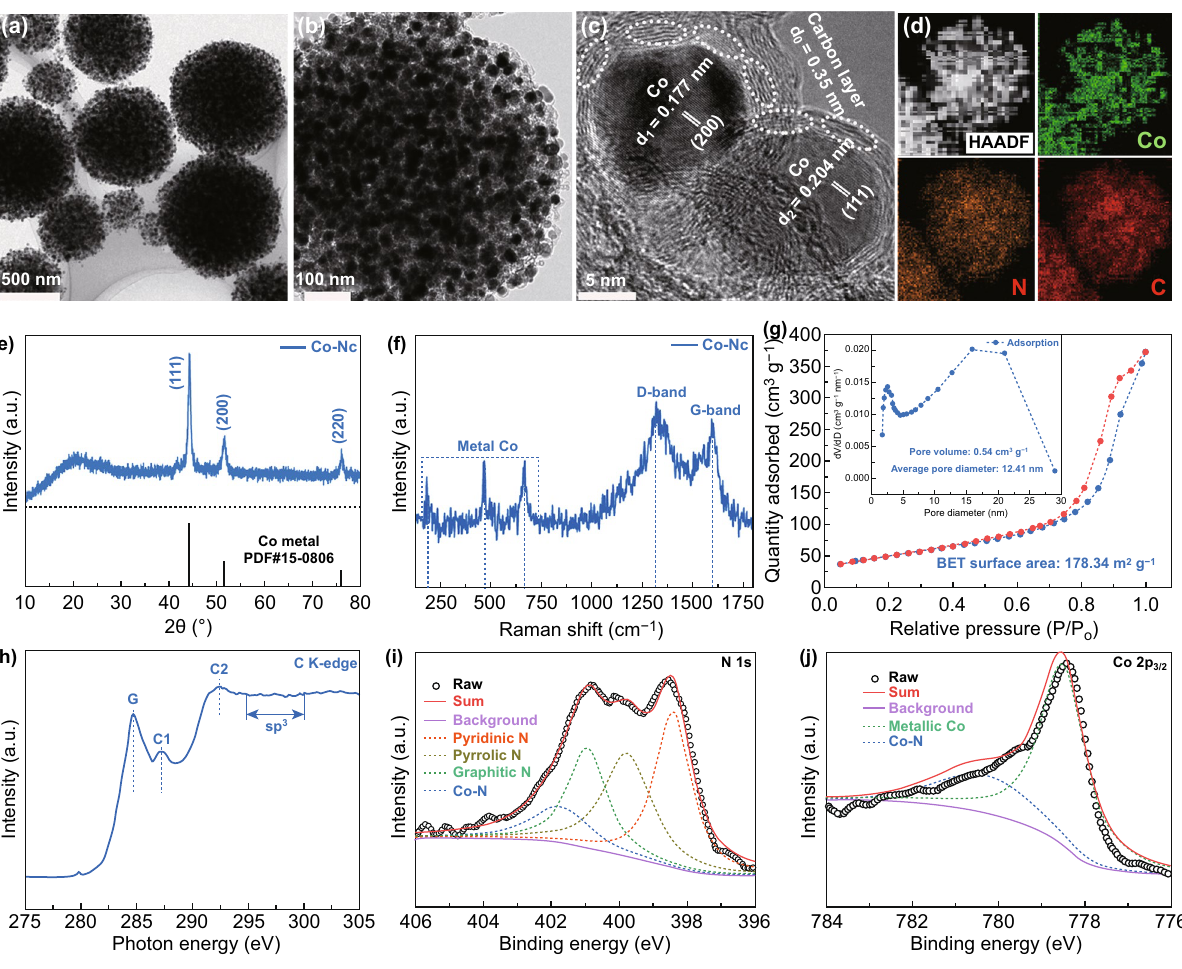
Fig. 1 a , b TEM images, c HRTEM image, d mapping images, e XRD pattern, f Raman spectra, g N 2 adsorption–desorption isotherm and pore distribution curves, h C K-edge XANES spectra, and i , j N 1 s and Co 2 p 3/2 spectra of Co-NC